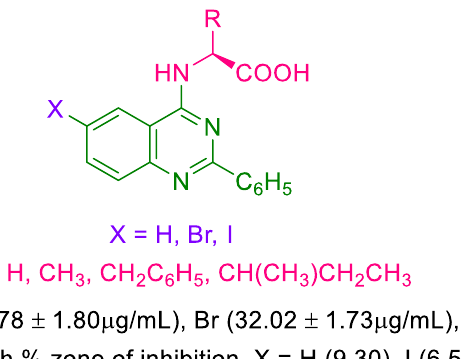
Figure 21. 4,6-disubstituted quinazoline- α -amino acid hybrid molecules.